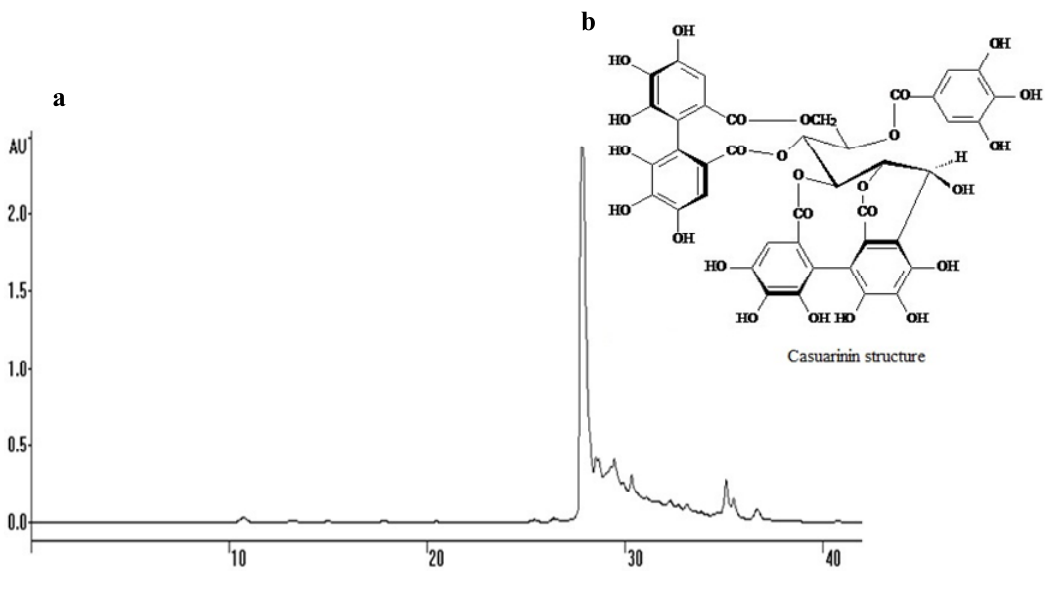
Figure 1. ( a ) Semi-preparative HPLC-UV chromatogram of F2 from P. cauliflora leaves. Chromatographic conditions: HPLC with UV detector set at 254 nm, the column was RP-18, elution phase acidified with trifluoroacetic acid 0.05% in linear gradient elution of OH/H O (20:80 in 15 min, 20:80 → 50:50 in 35 min, 50:50 → 95:5 in 40 min); flow-rate CH 3 2 of 2.5 mL/min. ( b ) Structure of casuarinin. This hydrolysable tannin is a C